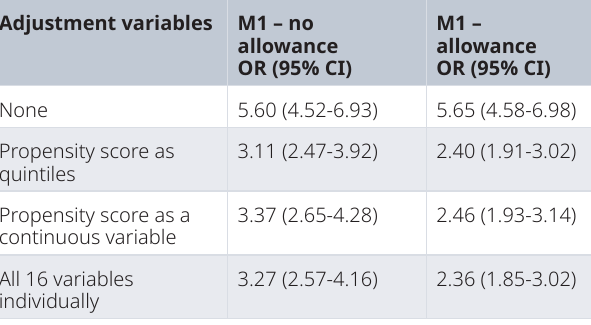
Table 7. Effect of allowance for residual confounding in main analysis